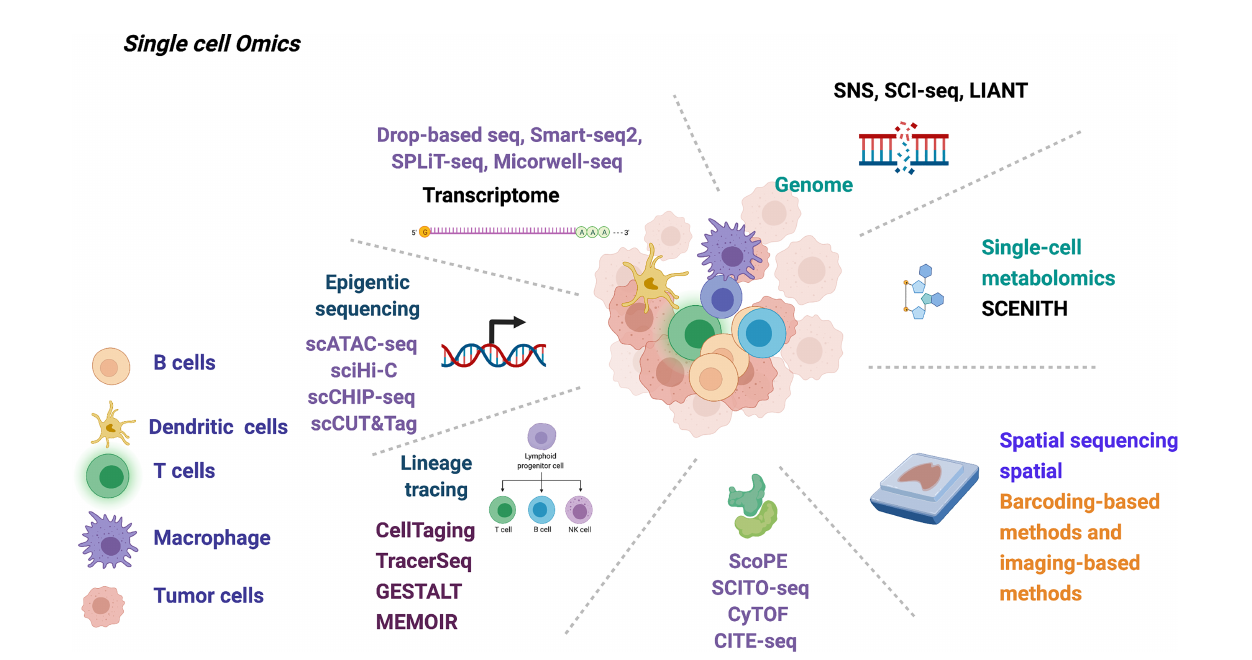
FIGURE 2 | Summary of current single-cell multi-omics technology that may be used in deciphering the early-stage lung cancer